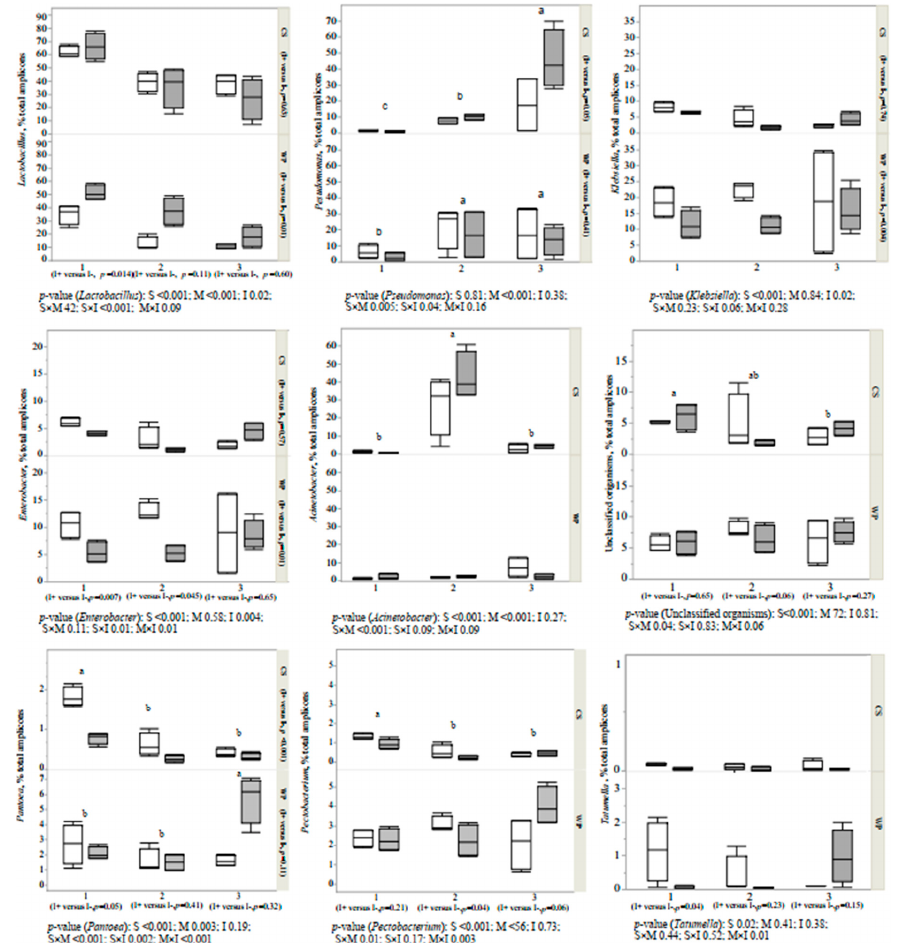
Figure 6. Effects of substrate, ensiling time, and inoculation of Lactobacillus plantarum on bacterial relative abundance (>0.5%) in silage (n = 4). Substrates are shown in panels. CS, sweet corn stover; WP, sweet corn whole plant. Sampling time points (months after ensiling) are scattered along the x axis. Inoculation with Lactobacillus plantarum is indicated with gray filling in the box plots. p values for the following effects are provided in legends below the graph: M, Months after ensiling; S, substrate; I − , not inoculated; I+, inoculated; S × M; interaction between substrate and month; S × I; interaction between substrate and inoculation; M × I; interaction between month and inoculation. adc Unlike- lower case letters within a substrate panel differ ( p <